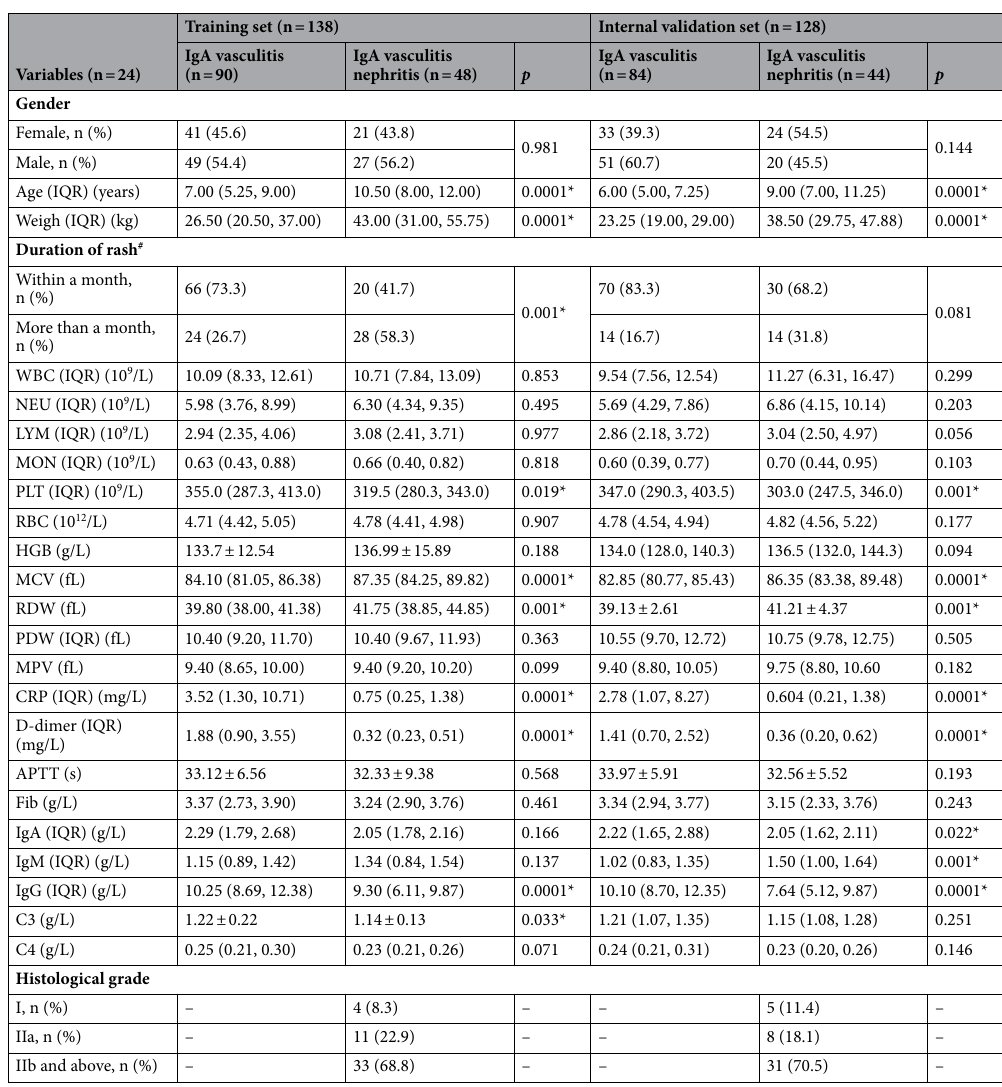
Table 1. Characteristics of the pediatric patients with IgA vasculitis and IgA vasculitis nephritis. * p < 0.05 for significance. # Means the time of rash recurrent or persistent. WBC white blood cell, NEU neutrophil, LYM lymphocyte, MON monocyte, PLT platelet, RBC red blood cell, HGB hemoglobin, MCV mean corpuscular volume, RDW red cell distribution width, PDW platelet distribution width, MPV mean platelet volume, CRP c-reaction protein, APTT activated partial thromboplastin time, Fib . fibrinogen, IQR interquartile